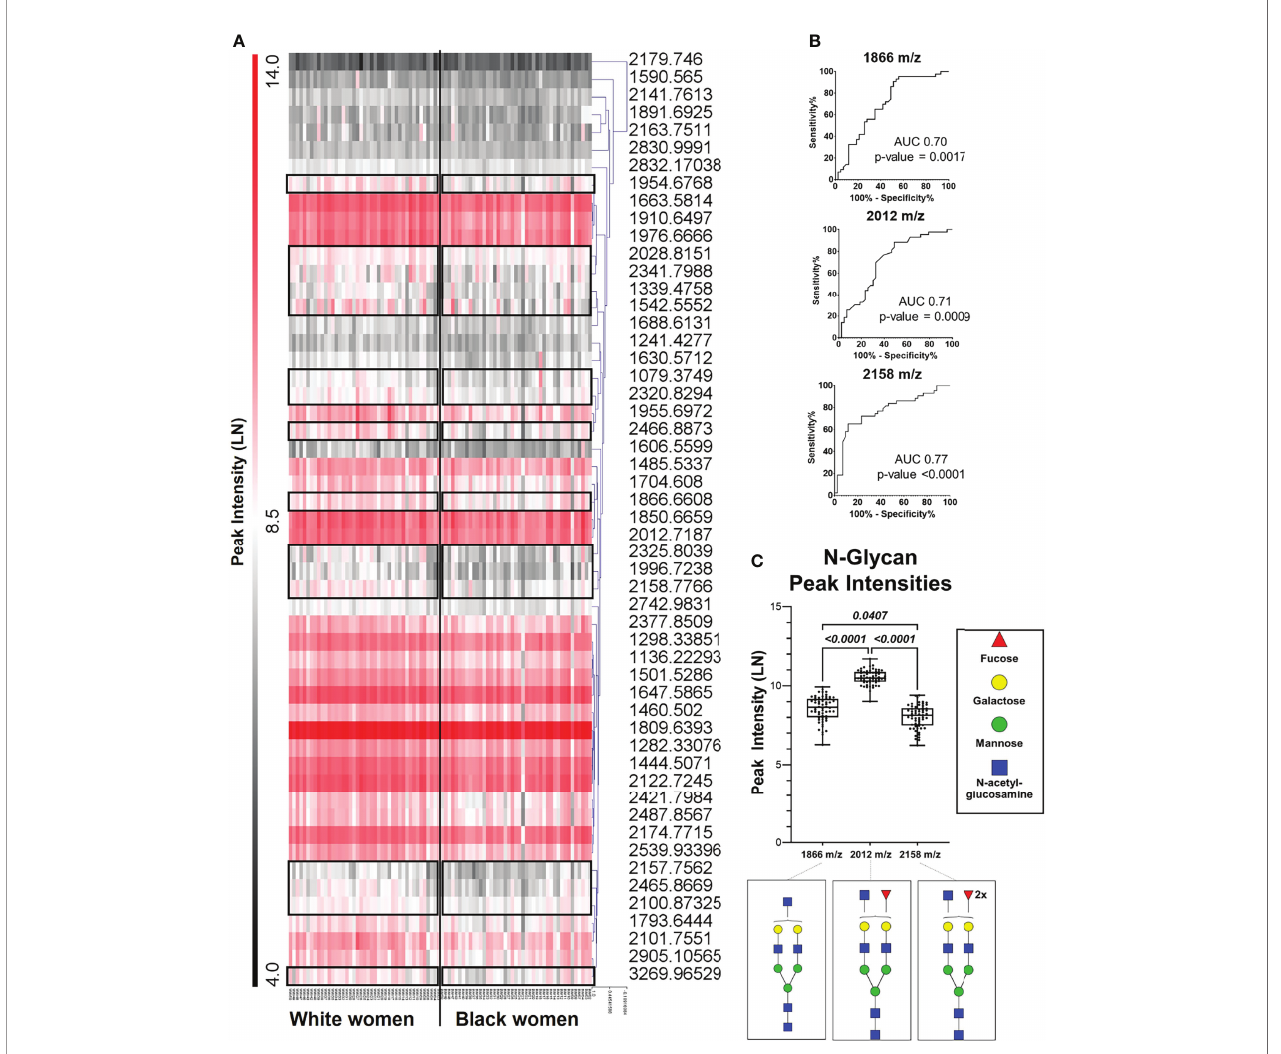
FIGURE 1 | Speci fi c N- Glycan patterns are observed among women at risk for breast cancer. (A) Hierarchal cluster heat map of 53 N-glycan from all patient samples with black boxes highlighting differences between Black women and white women. (B) Receiver operating curve (ROC) analysis of peaks 1866 m/z, 2012 m/z, and 2158 m/z showed area under the curve (AUC) values of 0.70, 0.71 and 0.77, respectively (p- value <0.005). (C) Peak intensity box plots of peaks 1866 m/z (HexHexNAc5), 2012 m/z (Hex5dHex1HexNAc5), and 2158 m/z (Hex5dHexHexNAc5)corresponding to a non-fucosylated, singly- fucosylated biantennary